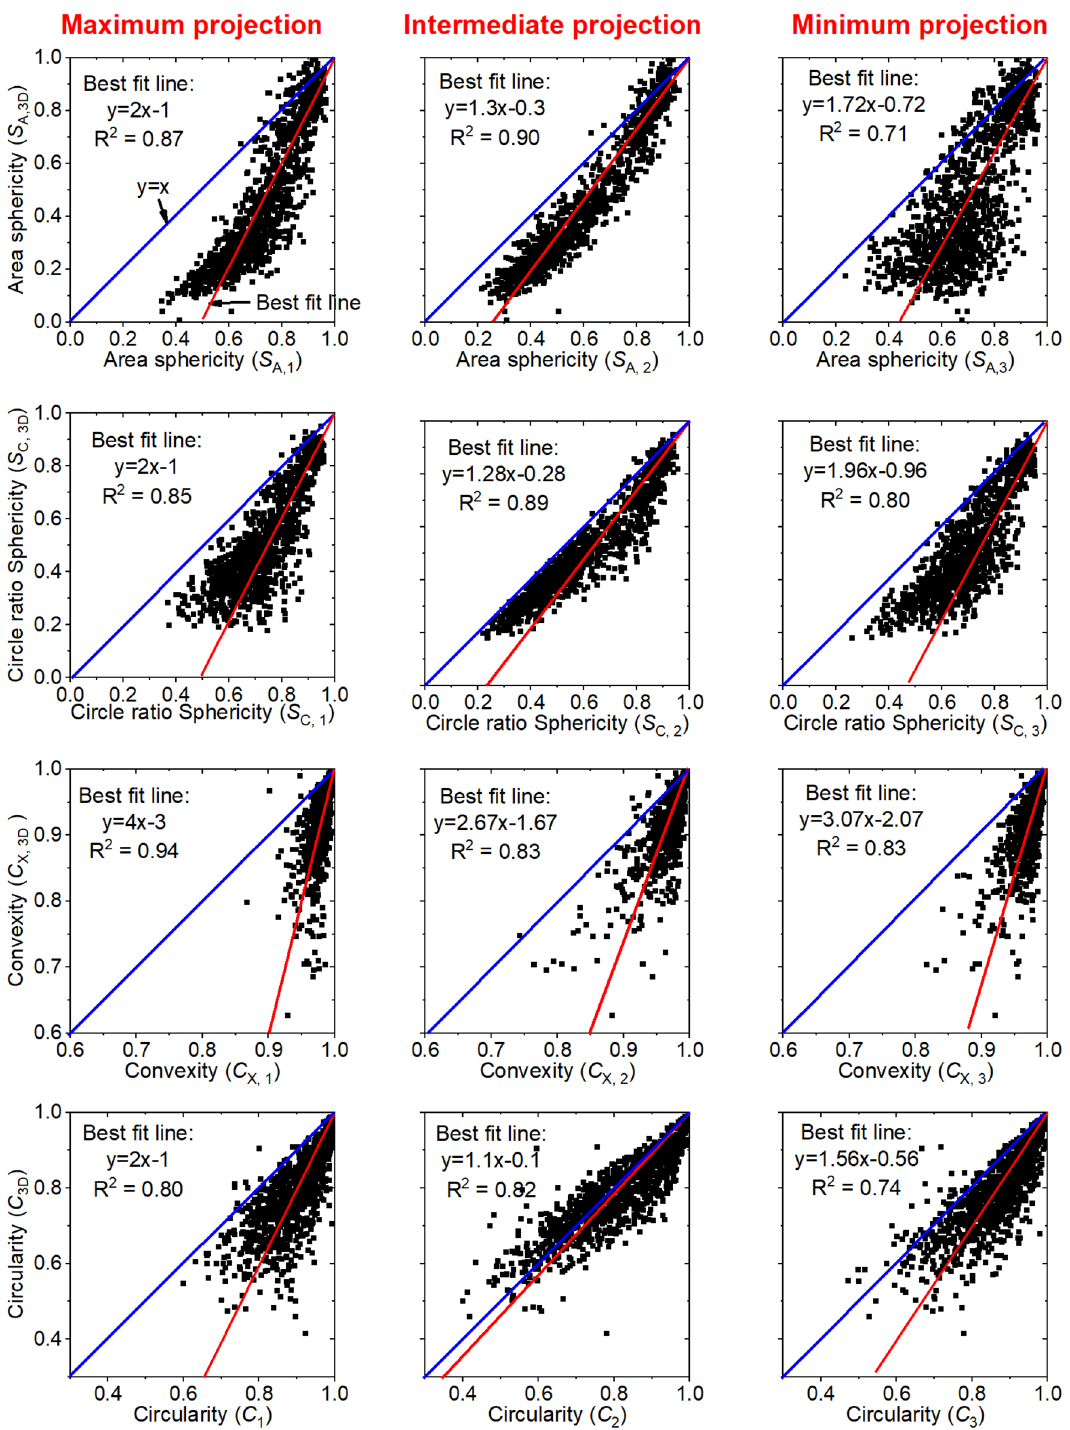
Fig. 10 Relationships between 2D vs. 3D image-based area sphericity, circle ratio sphericity, convexity, and